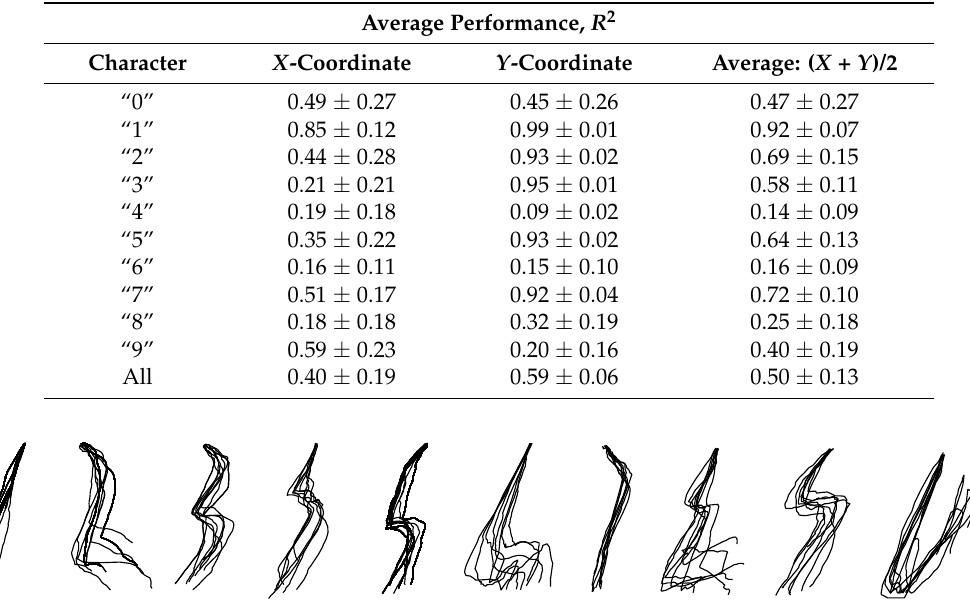
Table 3. Within-group reconstruction performance by the KF-GEP: the average accuracy of each numeric character across the five subjects.